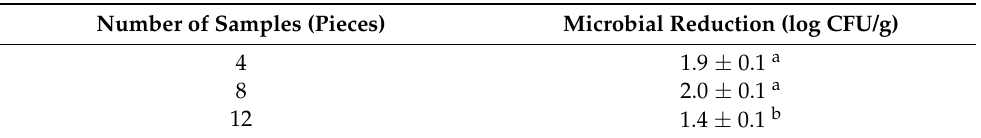
Table 2. Effects of the number of Korean rice cakes on the microbial inactivation efficiency of in-package cold plasma (CP) treatment against indigenous aerobic mesophilic